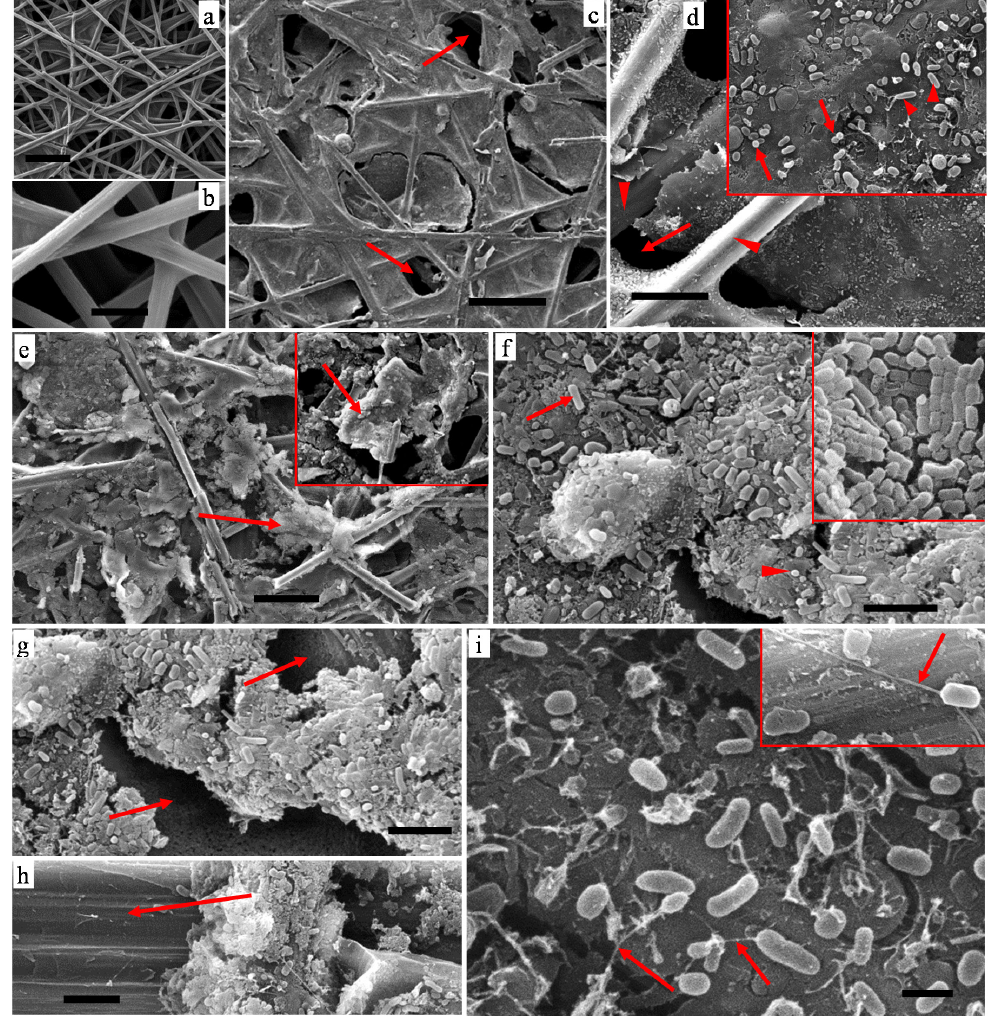
Figure 5. Scanning electron micrographs (SEM) of CP biofilms: ( a , b ) CP before inoculation showing interconnected network of smooth carbon strands; ( c , d ) CP ‐ GW inoculation; ( e – i ) CP ‐ FS inoculation. Bars: a,c, 100 μ m; b,d, 20 μ m; e, 50 μ m; f,g,h, 5 μ m; i, 1 μ m.